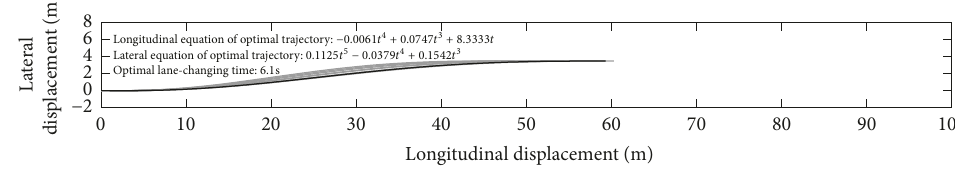
Figure 9: Lane-changing trajectory set of 𝑀 with the deceleration coordination of 𝐹 𝑑